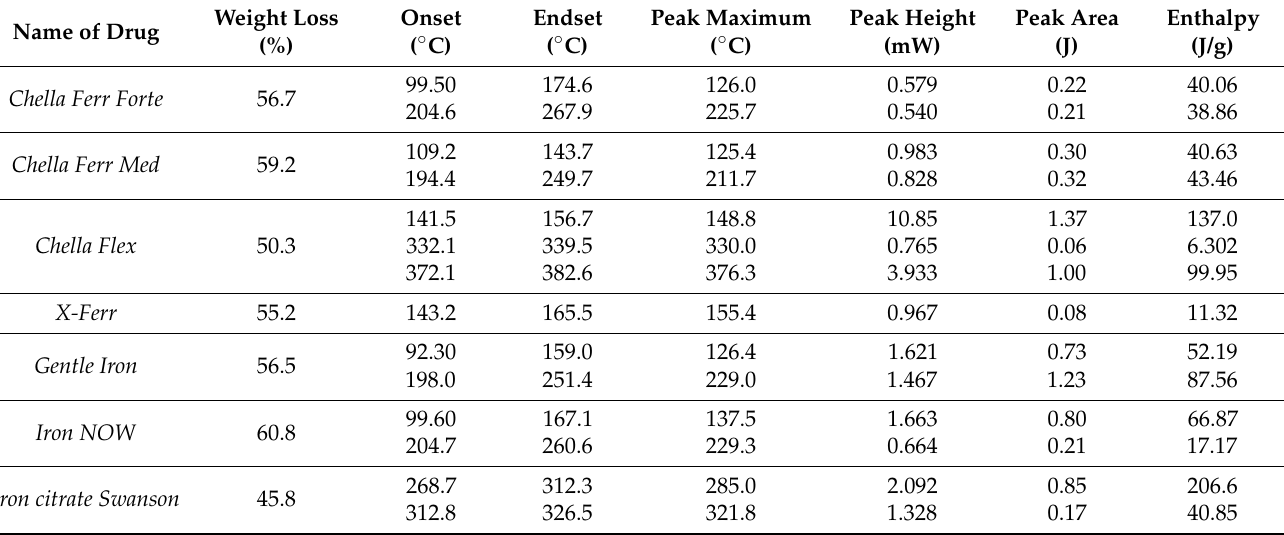
Table 9. Parameters determined from TG and DSC analysis for drugs containing iron (II) bisglycinate and iron (III)